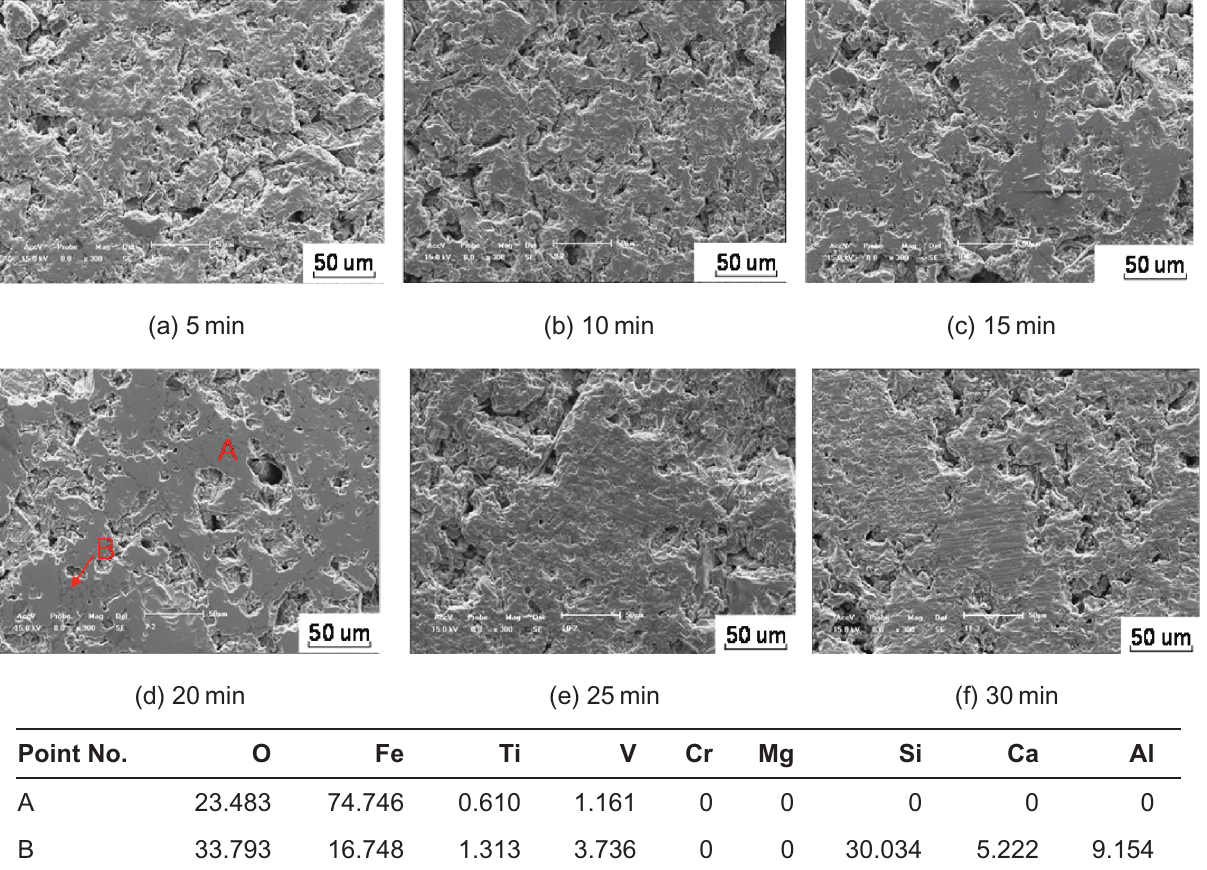
Figure 12: SEM images with EDS analyses (mass %) of HCVTM pellet roasted at 1,573 K at different